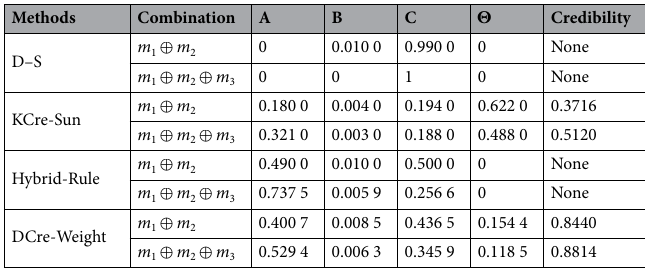
Table 1. Comparison of the fusion process under the four combination